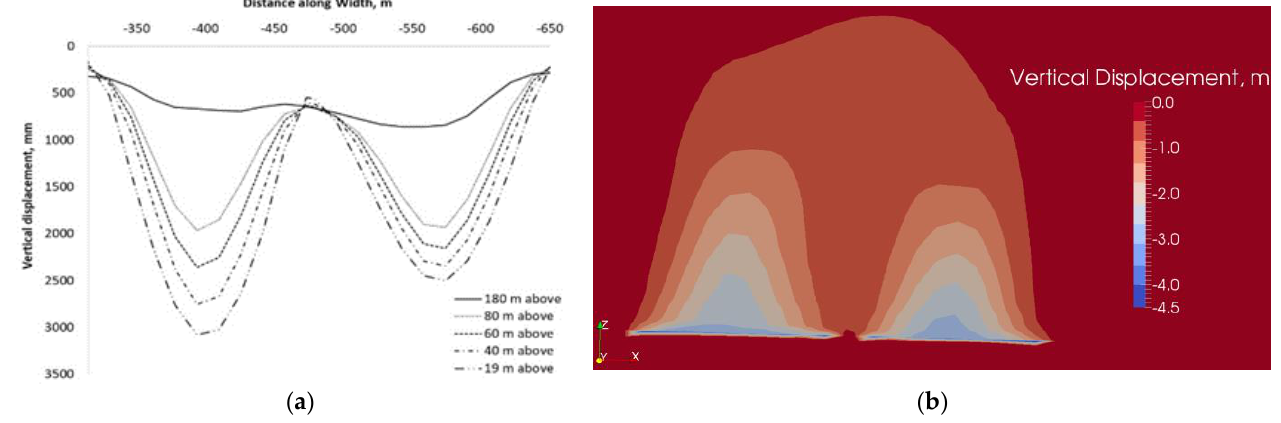
Figure 4. ( a ) Strata deformation above longwalls 203 (left trough) and 204 (right trough); ( b ) Sketch of the overburden deformation zone in